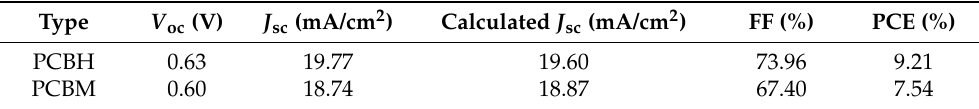
Table 2. Summary of device performance analysis in Figure 3. The calculated Jsc values were obtained from the EQE